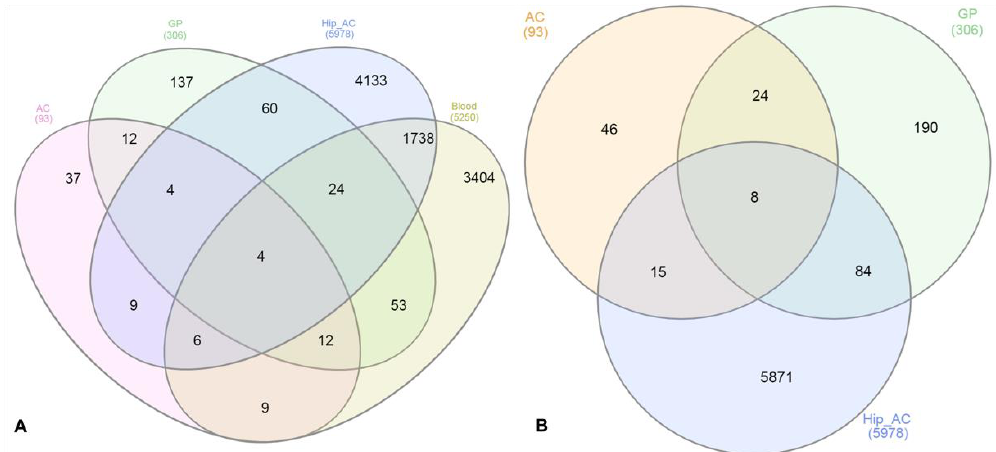
Figure 6. ( A ) Venn diagram constructed with DE genes from normal and femoral head necrosis and/or FHS-affected samples in four evaluated datasets. AC: chicken femoral articular cartilage; GP: chicken femoral growth plate; Hip_AC: human articular cartilage; Blood: human peripheral blood.